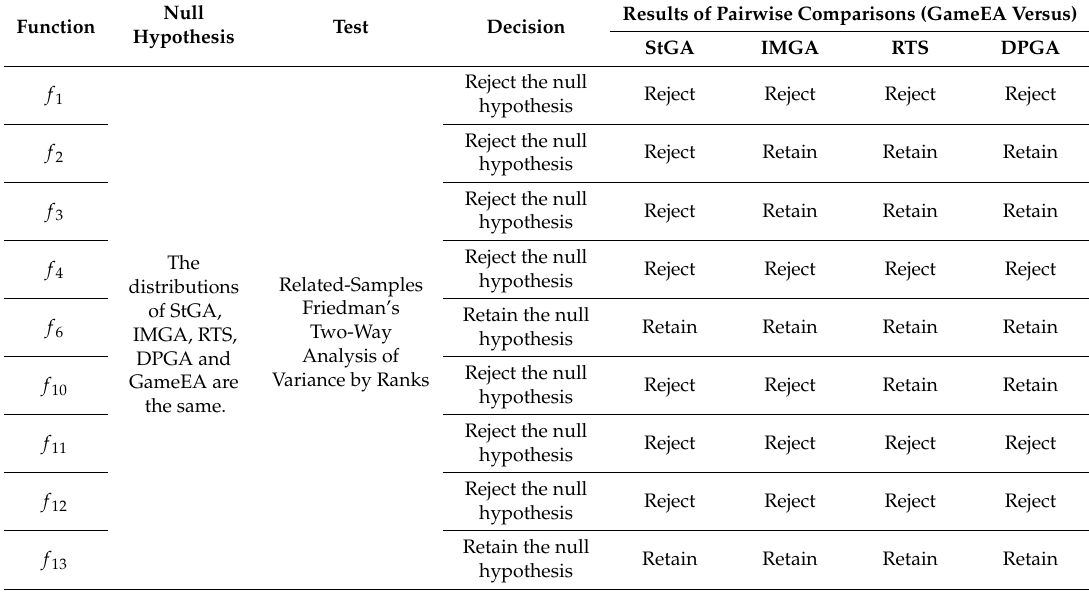
Table 4. Hypothesis test summary and results of the pairwise comparisons.